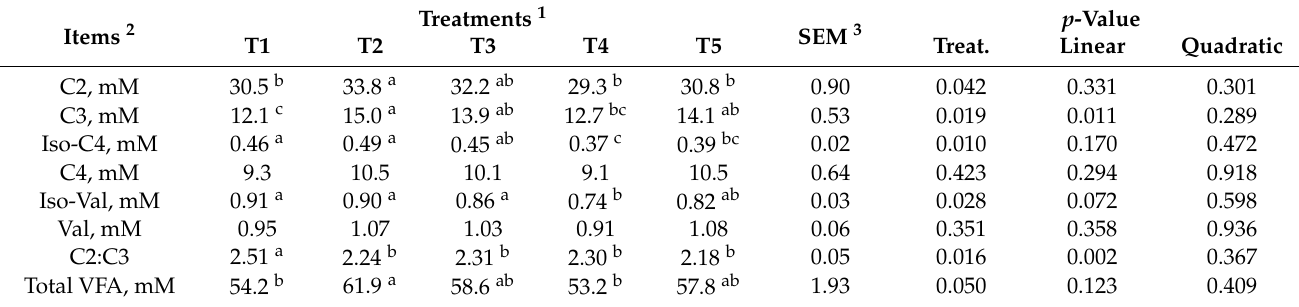
Table 7. Volatile fatty acids (VFA) during the in vitro fermentation for dietary treatments with sprouted barley different